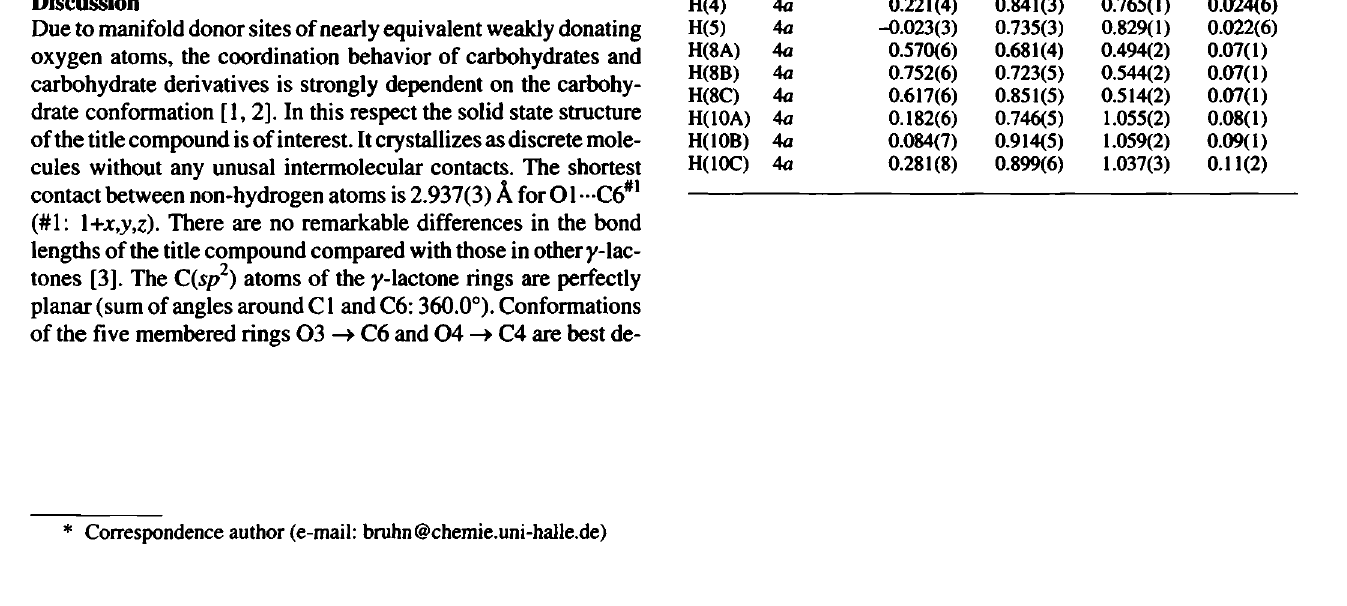
Table 2. Atomic coordinates and displacement parameters (in Â 2